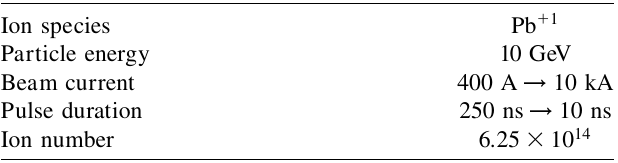
TABLE I. Parameters of one beam for the final bunching stage in HIF